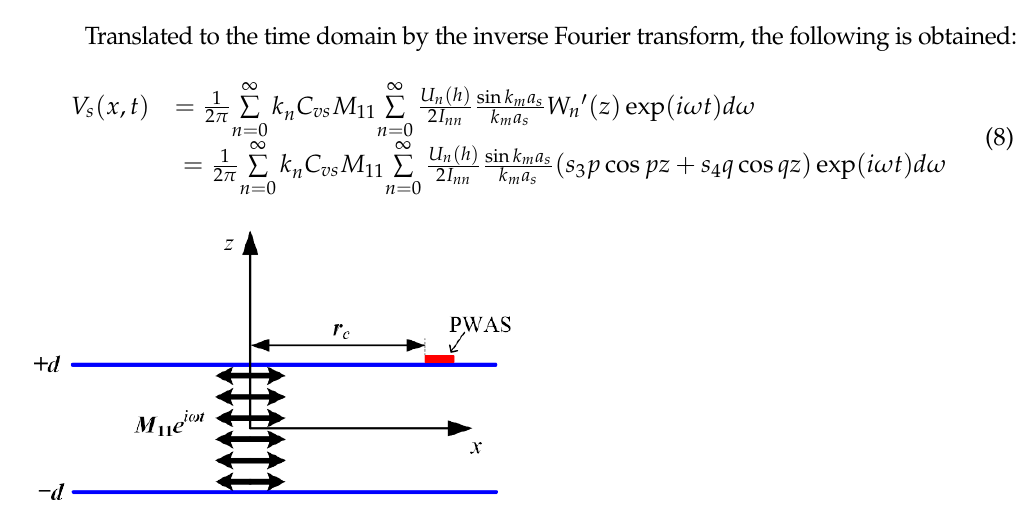
Figure 3. M11 excitation through plate thickness in thin plate.